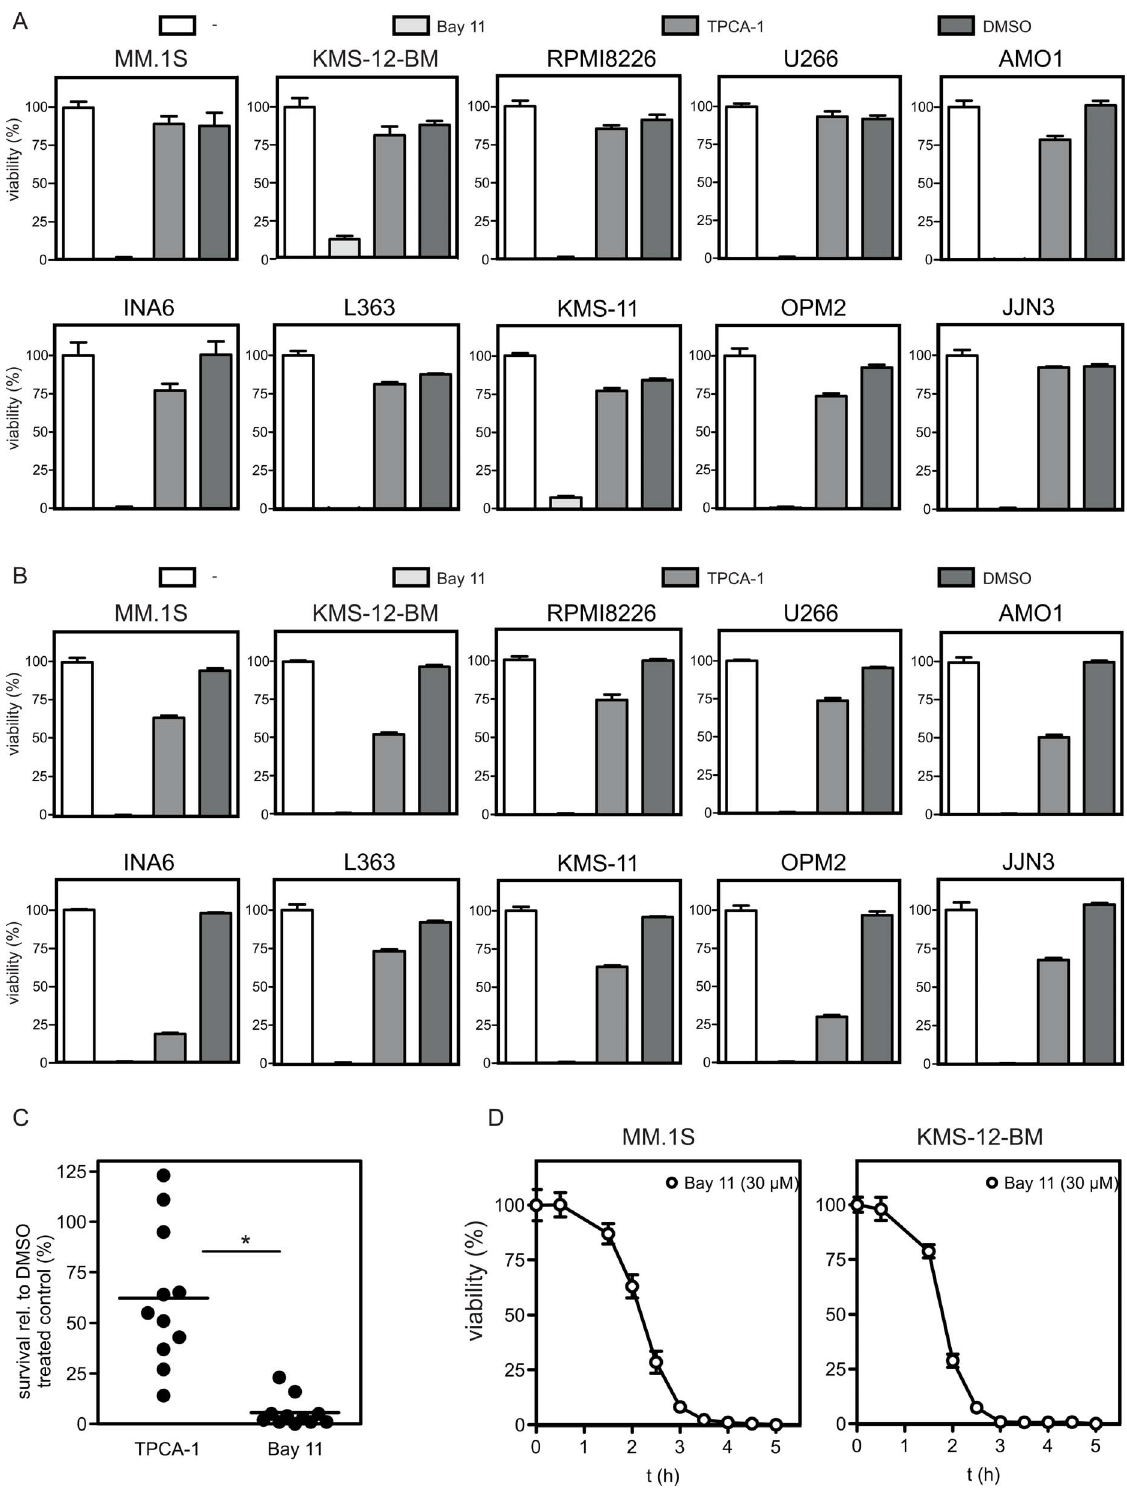
Figure 2. Effects of IKK inhibitors on MM cell viability. (A,B) MM cell lines were challenged with either TPCA-1 (20 m M) or Bay 11-7082 (30 m M) for 4 h (A) and 18 h, respectively (B), and analyzed for viability using the MTT assay. (C) Primary MM samples (n=11) in co-culture with BMSCs were incubated with either TPCA-1 (20 m M) or Bay 11-7082 (30 m M) for 3 days and cell death was determined by annexin V-FITC/PI staining and flow cytometry (relative values with respect to the DMSO-treated controls shown; horizontal lines indicate the mean). Data were analyzed using a two- tailed, paired t-test. Asterisk indicates a p - value , 0.01. (D) MM.1S and KMS-12-BM cells were challenged with 30 m M Bay 11-7082 for the indicated time. Triplicate values were taken and cellular viability was determined using the MTT assay.